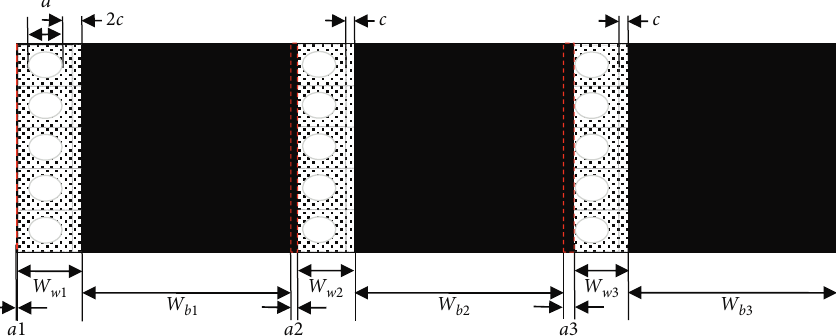
Figure 2: Structure of the malposed parallax barrier with discrepant width of slits, W respectively.